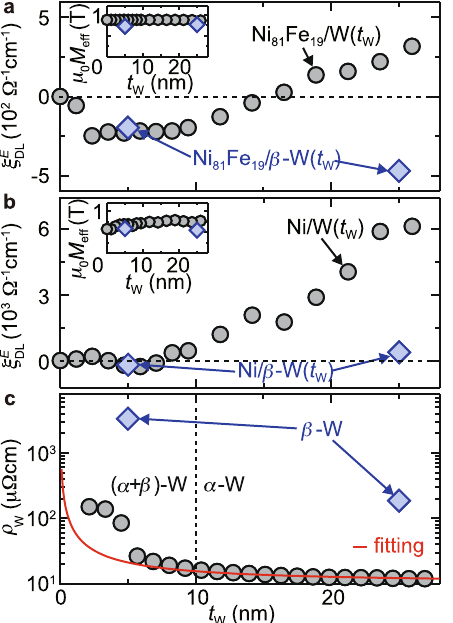
Fig. 3 Current-induced torque generated by W. a W-layer-thickness t W dependence of ξ E for the Ni 81 Fe 19 (5 nm)/W( t W ) (black circles) and DL Ni 81 Fe 19 (5 nm)/ β -W( t W ) (blue diamonds) bilayers. The inset shows t W dependence of M eff . Error bars, one-standard-deviation uncertainties from the fi tting, are smaller than the symbols. Here, ξ E (blue diamonds) of the DL Ni 81 Fe 19 / β -W with t W = 5 nm is smaller than that of the Ni 81 Fe 19 / β -W with t = 25 nm, even though both torques are dominated by the spin Hall effect W in the β -W layer. This difference can be attributed to the suppression of the intrinsic spin Hall conductivity in the dirty-metal regime due to the shortening of the carrier lifetime induced by decreasing t W . This interpretation is supported by the fact that the resistivity of the β -W fi lm increases with decreasing the thickness from t W = 25 nm to t W = 5 nm, as shown in Fig. 3c. for the Ni(8 nm)/W( t W ) (black circles) and Ni(8 b t W dependence of ξ E DL nm)/ β -W( t W ) (blue diamonds) bilayers. c t W dependence of the resistivity ρ β -W (blue diamonds) fi lms. The resistivity W for the W (black circles) and shows that the W fi lm (black circles) is α -W when t W >10 nm and the mixture of α - and β -phase W when t W <10 nm. The red curve is the fi tting ð t Þ ¼ at (cid:2) 1 þ ρ bulk result using ρ , where at (cid:2) 1 represents the resistivity due W W W W W to the surface scattering and ρ bulk is the resistivity in the bulk W